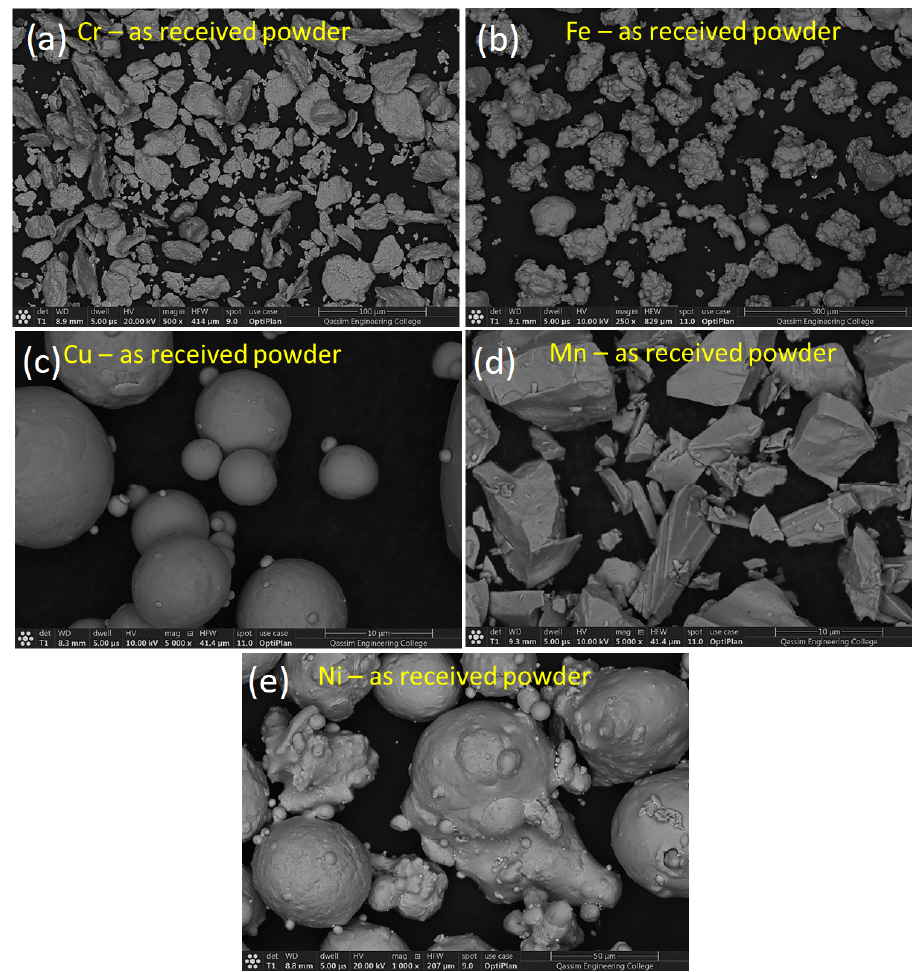
Figure 3 . HRSEM powder surface morphology of as-received metallic elemental powders: ( a ) Cr; ( b ) Fe; ( c ) Cu; ( d ) Mn; and ( e ) Ni .